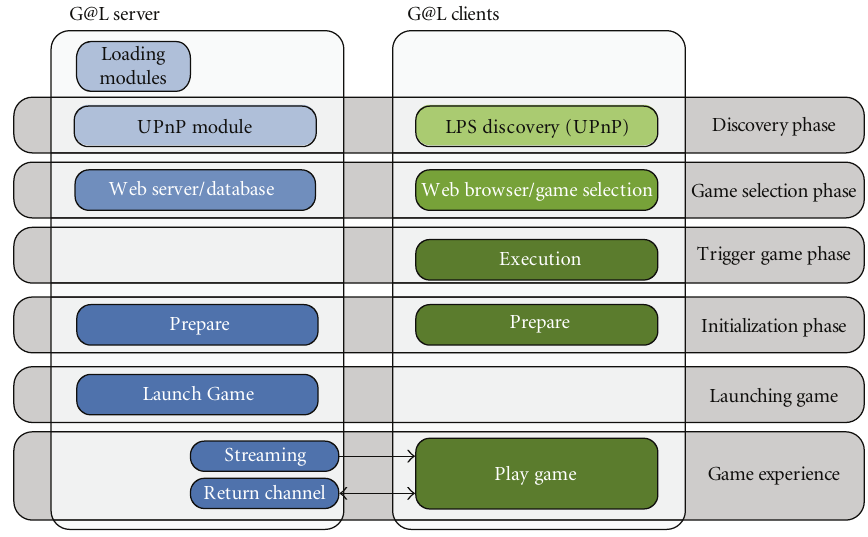
Figure 7: General flow of information.